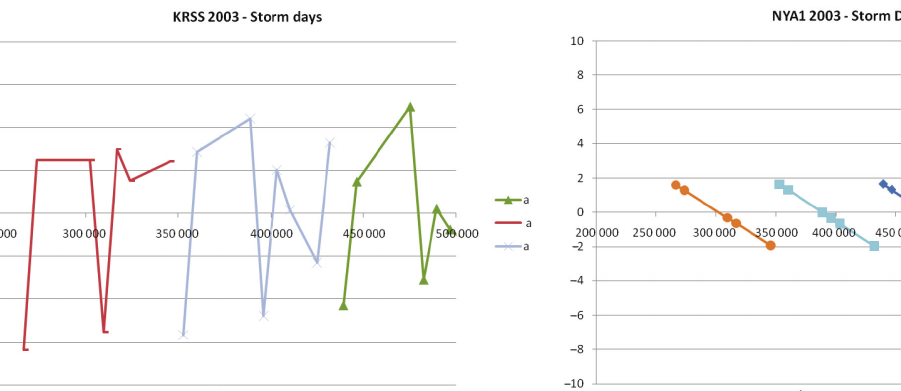
Fig. 5. argument of perigee of three stormy days in 2003 using cPOS stations (KRSS)